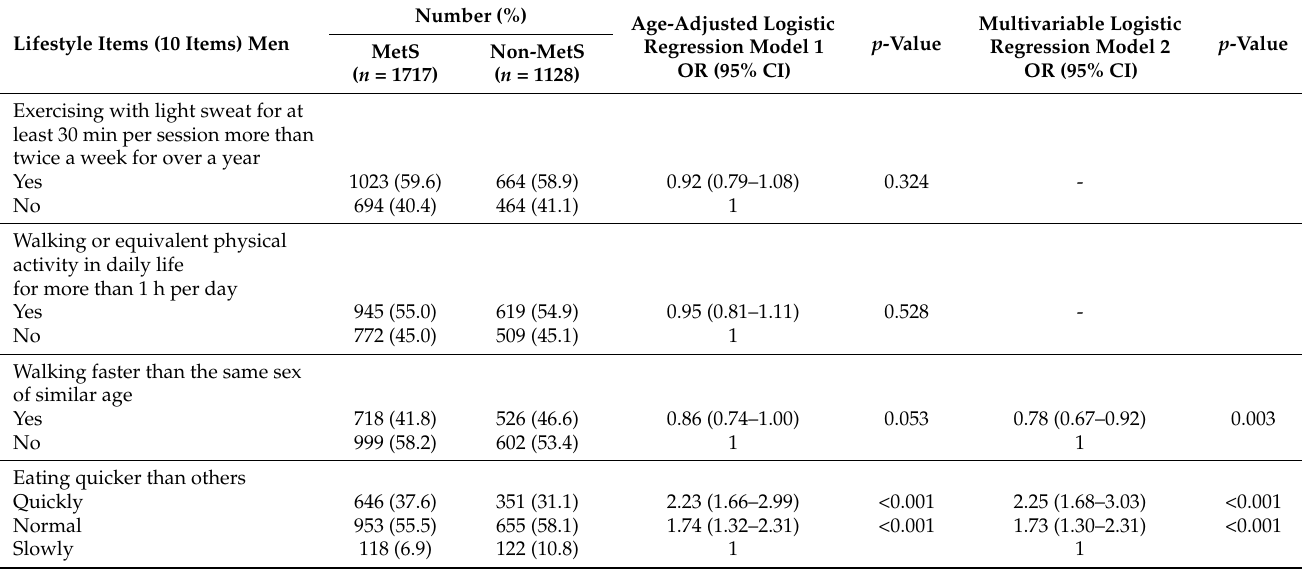
Table 3. Association between metabolic syndrome and lifestyle